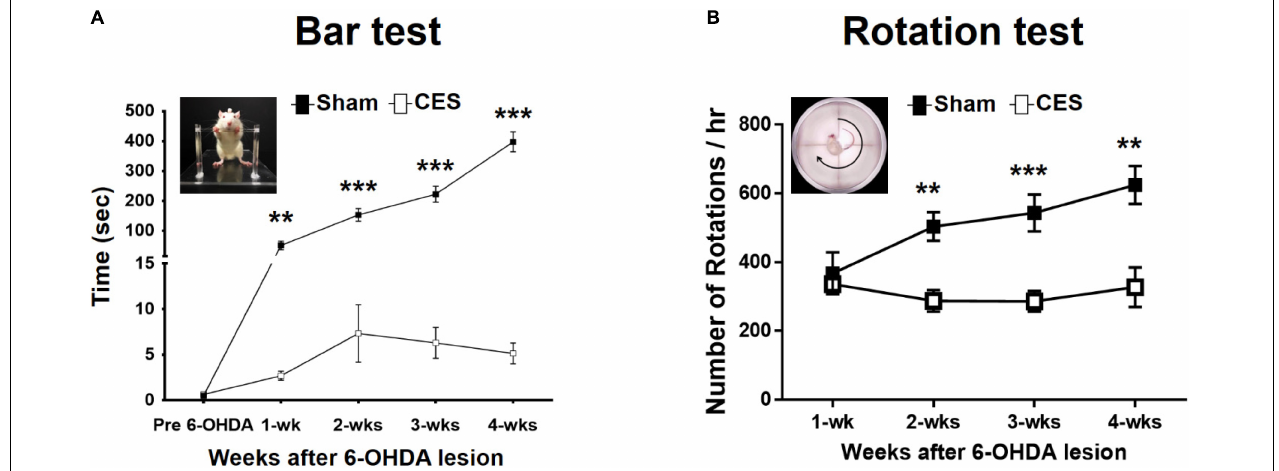
FIGURE 3 | Time-course analysis of bar test (A) and apomorphine-induced rotational behavior (B) in the sham-CES-treated and CES-treated groups after the 6-hydroxydopamine (6-OHDA) lesions. Values are shown as means ± SEMs. * p < 0.05, ** p < 0.01, and *** p < 0.001; each indicates significant difference between the two